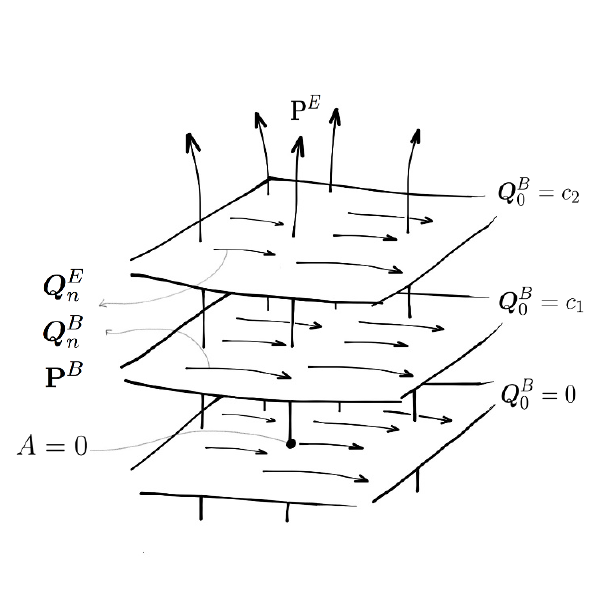
Figure 3 . The phase space of soft charges and a depiction of (2.36). The horizontal planes depict con(cid:12)gurations of given constant magnetic charge. P E moves us between these horizontal planes while Q E , Q B and P B move us on each constant Q B plane. Vertical arrows show (cid:13)ows generated n n 0 by P E and corresponds to addition of a Dirac string piercing the celestial sphere and appears as a surface magnetic charge for the local boundary observers. One could have drawn a similar (cid:12)gure using any other conjugate pairs of charges instead of P E and Q B , e.g. P B and Q E . This (cid:12)gure 0 0 may be contrasted with the \just electric" residual gauge symmetry phase space which is usually considered in the Maxwell theory. In the absence of magnetic soft charges, the electric soft algebra is Abelian and hence action of residual electric gauge transformations does not create a (cid:13)ow on the phase